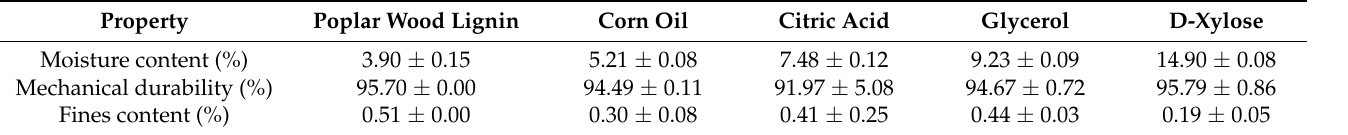
Table 6. Experimental results after a 30-day storage time at 22.3 ◦ C (first condition) for pellets manufactured from poplar wood lignin and additives (Scenario